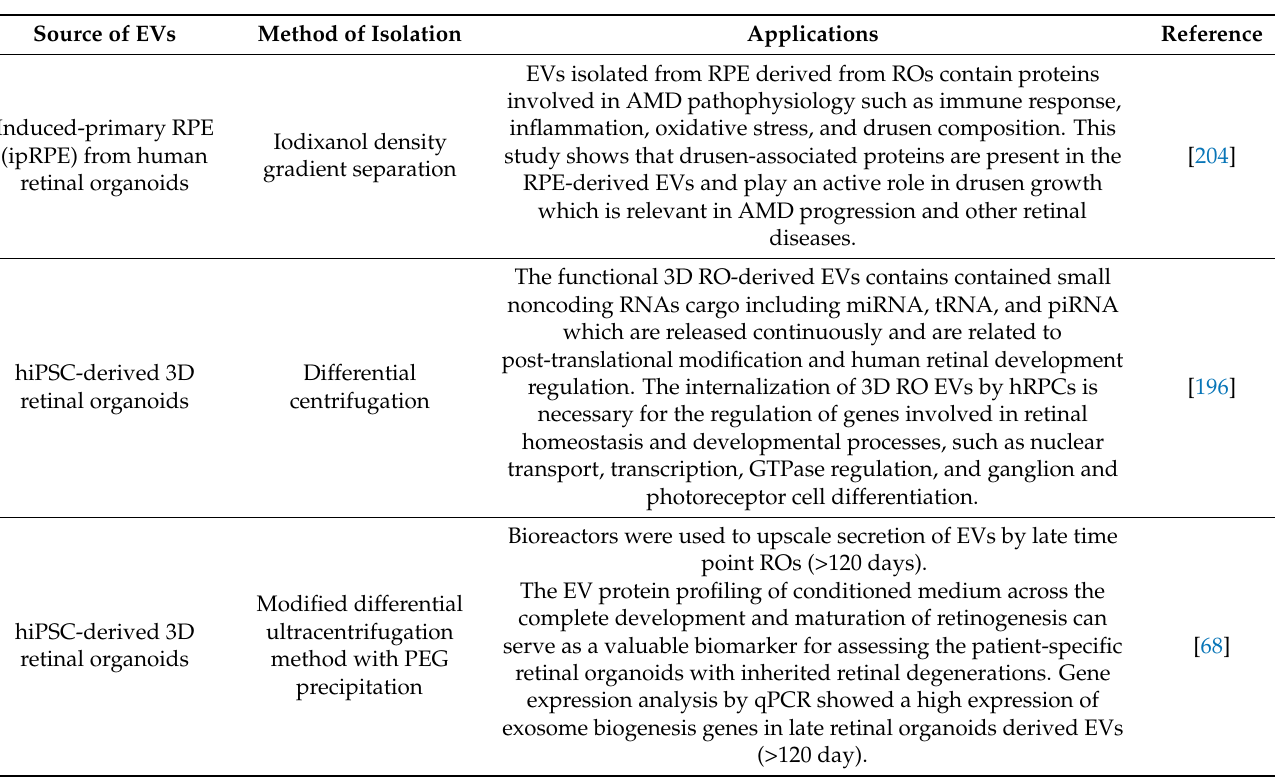
Table 3. Summary of retinal organoid-derived extracellular vesicles for ocular